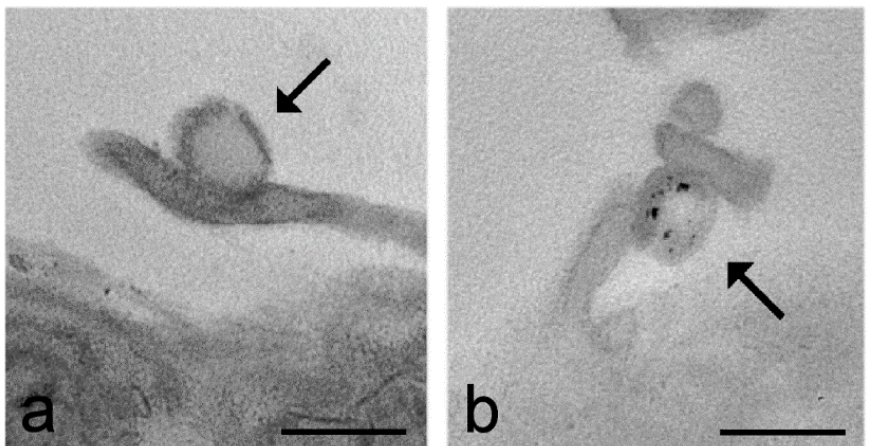
Figure 3. Transmission electron micrographs of C2C12 cells incubated for 2 h with hyaluronic acid- based nanoparticles (arrows). The sample in ( a ) was fixed with aldehydes, post-fixed with osmium tetroxide and embedded in epoxy resin and the sample in ( b ) was fixed with aldehydes, submitted to Alcian blue staining, post-fixed with osmium tetroxide and embedded in epoxy resin. Note the low electron density of the nanoparticles in the conventionally processed sample ( a ) and their increased visibility after the Alcian blue staining ( b ). Bars: 200 nm. Images from Carton et al. [90].